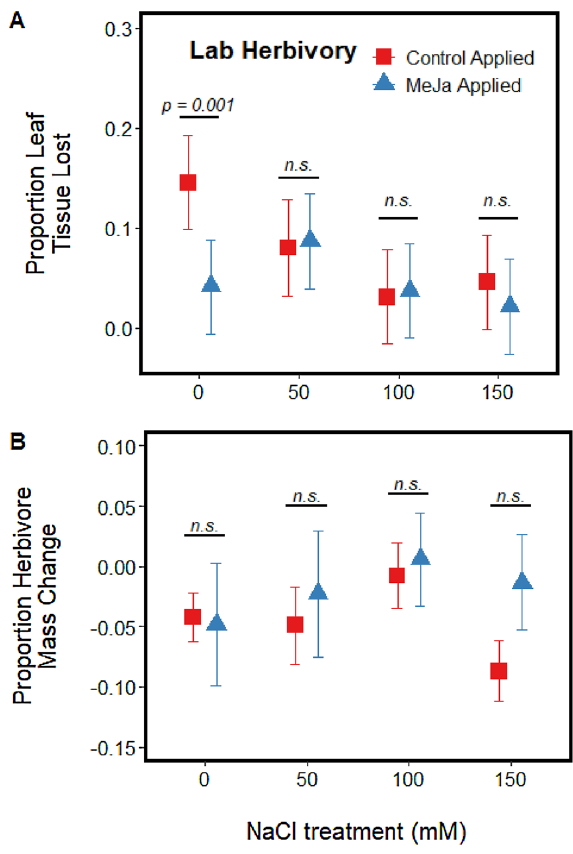
Figure 1. Effects of soil salinization at four concentrations of salt addition (0, 50 100, 150 mM NaCl) and plant induction via exogenous application of methyl jasmonate on ( A ) the proportion leaf tissue lost to generalist herbivore Spodoptera exigua and ( B ) the proportion change in herbivore mass during a 48 h no-choice laboratory feeding trial. Bars above each paired data points represent the results of a pairwise contrast testing the effect of chemical induction at each soil salinization level.